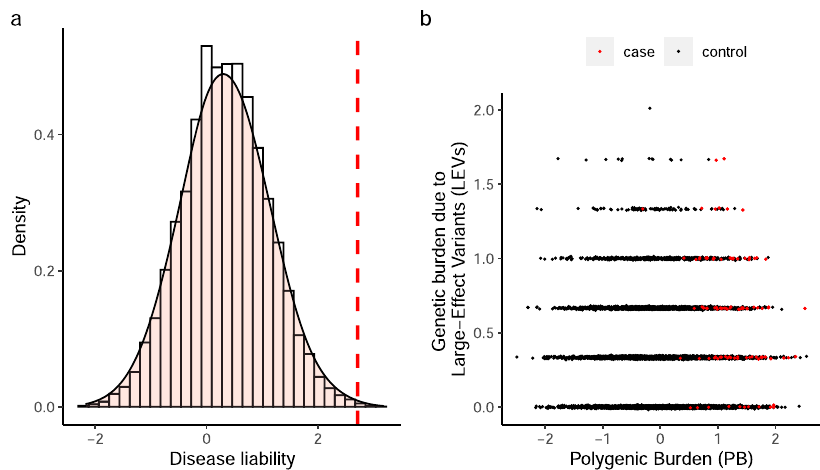
Fig. 1 Central hypothesis underlying relationship between polygenic burden and large-effect (typically rare) variant. For illustration here, we set the heritability due to the polygenic burden (PB), heritability due to large-effect variants (LEVs), and population prevalence to be 0.5, 0.1, and 0.01, respectively, and simulated N ¼ 10 ; 000 independent samples under the liability-threshold model of disease risk. Panel a shows the distribution of the underlying liability, a normally-distributed trait resulting from the cumulative effects of PB, LEVs, and the residual component. The red dashed line indicates the so-called liability threshold, which is determined by K , the population prevalence parameter. Panel b illustrates the relationship between the two orthogonal sources of genetic risk among individuals who share a diagnosis. Ideally, an inverse correlation of PB and LEV burden should be observed in cases (red dots, de fi ned by the threshold line in panel ( a )) under the liability-threshold model. In real-world data, the liability may include many additional effects not shown in this model. We refer to the inverse relationship between PB and LEV among cases (illustrated in panel ( b )) as the “ PB-LEV correlation ” . The PB-LEV correlation can then be used in downstream applications, e.g., predicting (for external validation) the proportion of LEV carriers